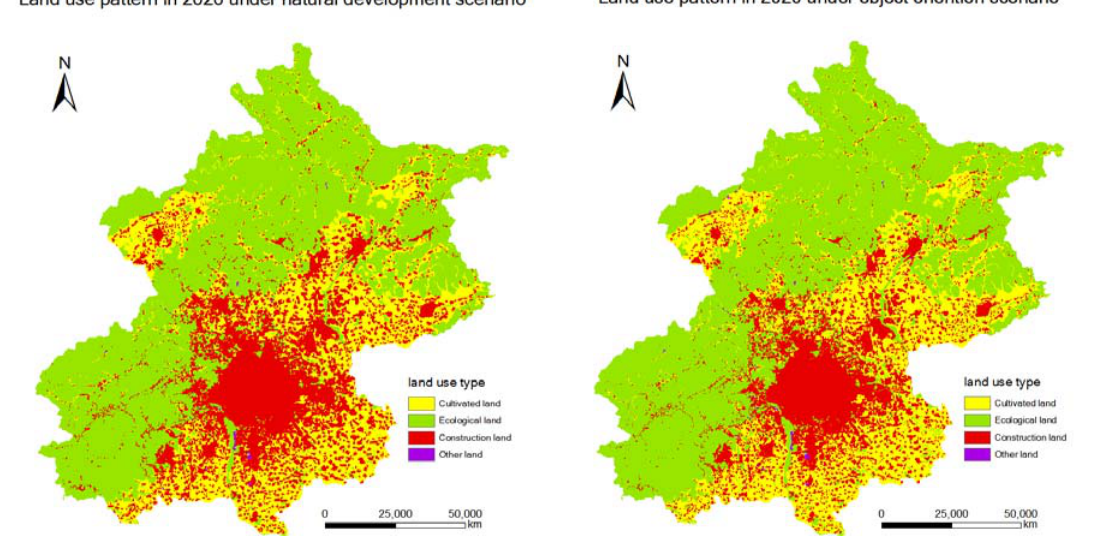
Figure 4. Development pattern of land use in 2020 of Beijing under different